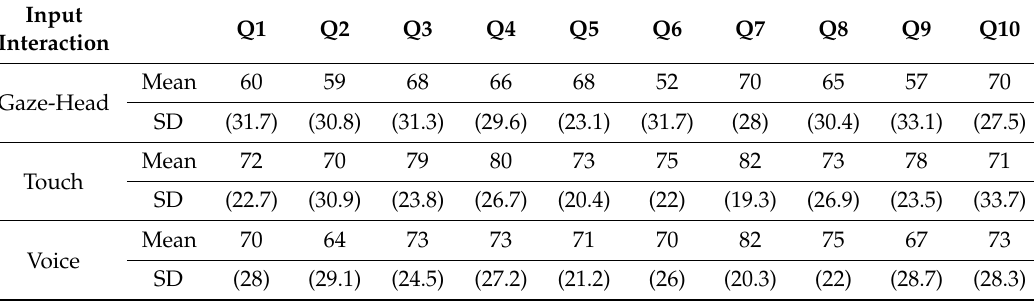
Table 1. The mean (M) and standard deviation (SD) values for the ten increment items of system usability scale scores for the three input interactions.